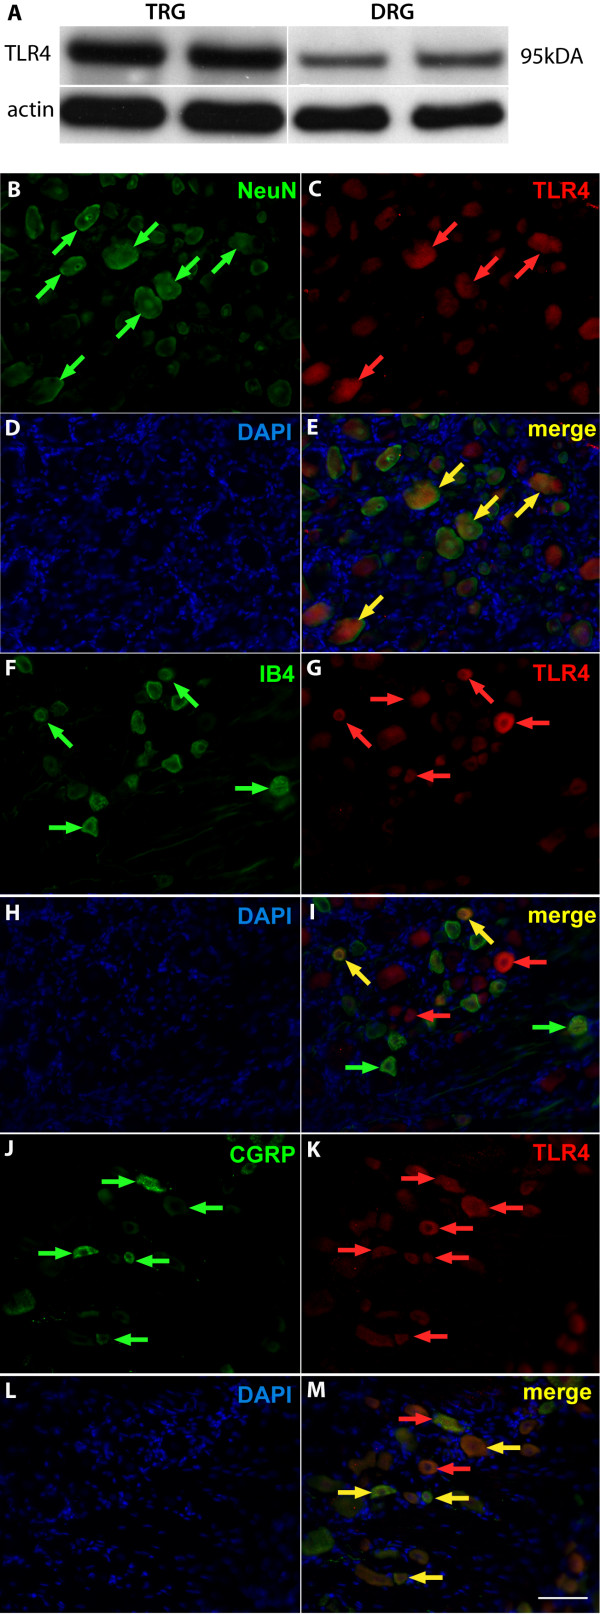
Toll-like receptor 4 expression in sensory neurons. (A) Western blot analysis of Toll-like receptor 4 (TLR4) isolated from trigeminal root ganglion (TRG) and lumbar L3-L6 dorsal root ganglion (DRG) lysates. (B-M) Immunofluorescent images of TLR4 in peptidergic and non-peptidergic DRG populations from sectioned naïve L4 or L5 DRGs. NeuN is a neuronal marker (B, green arrowheads), which co-labeled with TLR4 (C, red arrowheads). Nuclei are stained with DAPI (D, H, L, blue). Merged images demonstrate co-labeling of NeuN containing neurons with TLR4 (E, yellow arrowheads). Calcitonin gene-related peptide (CGRP) is a marker for peptidergic-containing sensory neurons (F, green arrowheads), which co-labeled with TLR4 (G, red arrowheads). Merged images demonstrate co-labeling of CGRP-containing neurons with TLR4 (I, yellow arrowheads). Isolectin B4 (IB4) is a marker for non-peptidergic sensory neurons (J, green arrowheads), which co-labeled with TLR4 (K, red arrowheads). Merged images show co-labeling of IB4 non-peptidergic sensory neurons with TLR4 (M, yellow arrowheads). Scale bar is 60 μm (B-M).